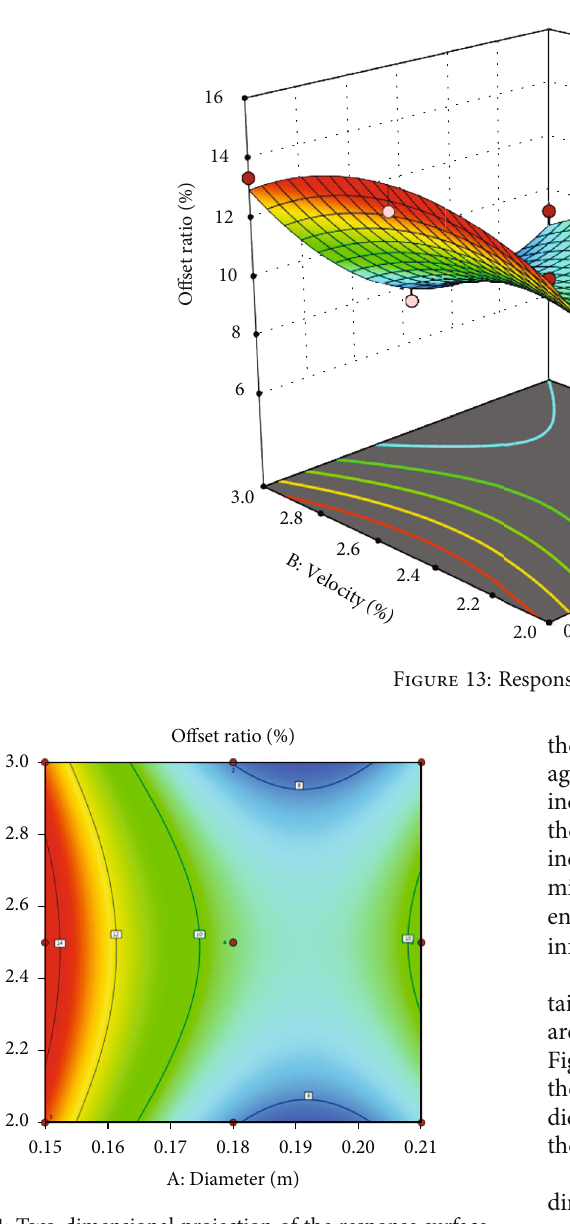
Figure 14: Two-dimensional projection of the response